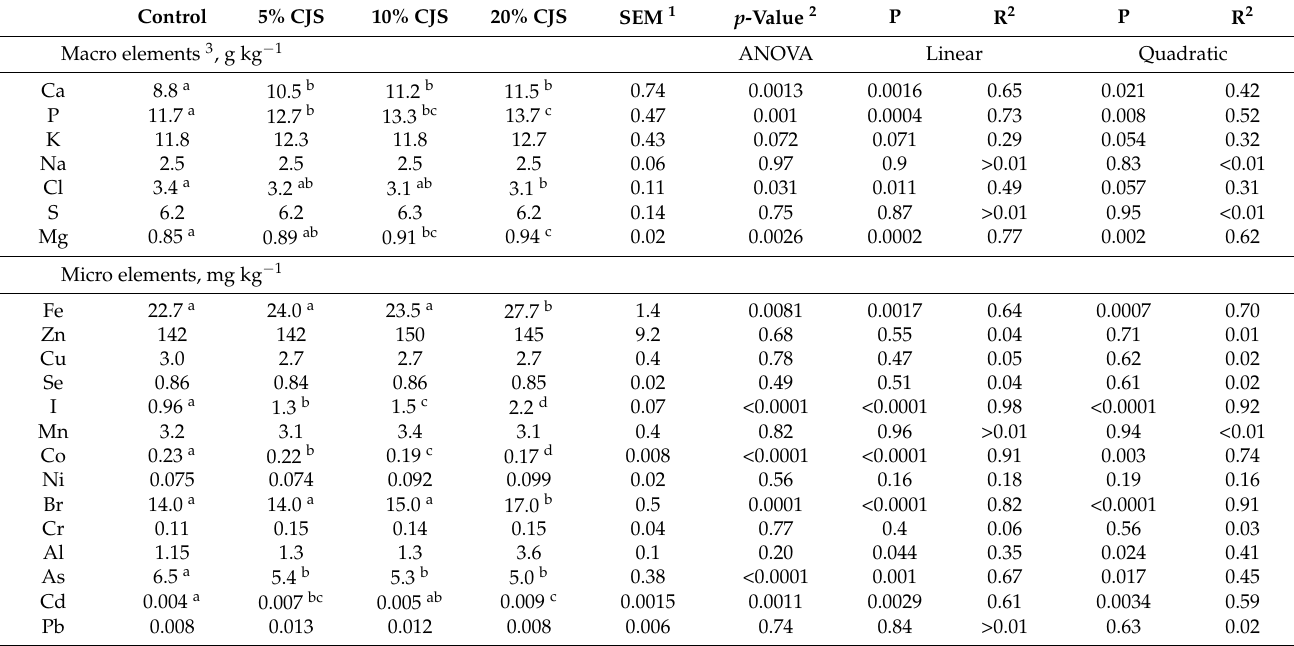
Table 6. Macro and micro minerals present in the whole body of Atlantic salmon ( Salmo salar ) from the retention experiment where the salmon were fed increasing dietary level of Cyberlindnera jadinii